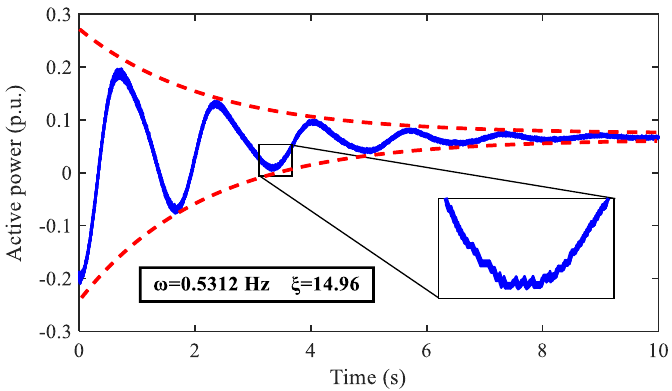
Figure 15. The measured response of tie-line active power.